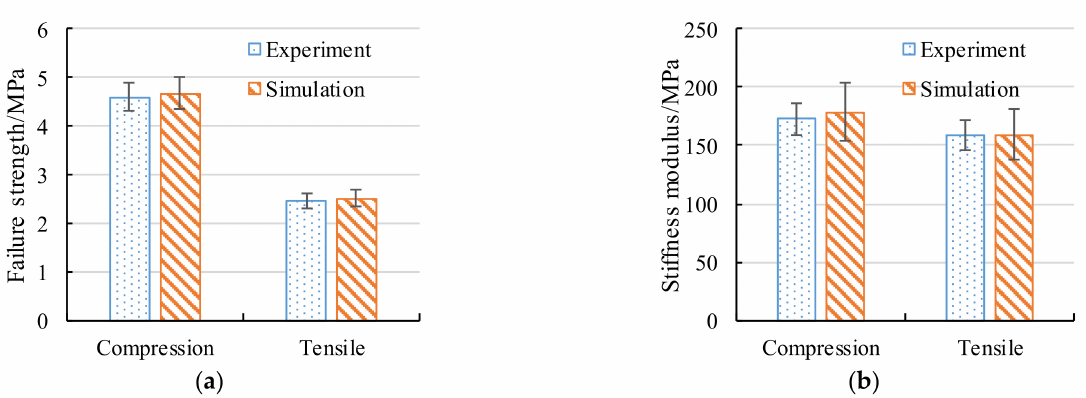
Figure 10. Failure strength and stiffness modulus of experiments vs simulations: ( a ) compression tests and ( b ) tensile